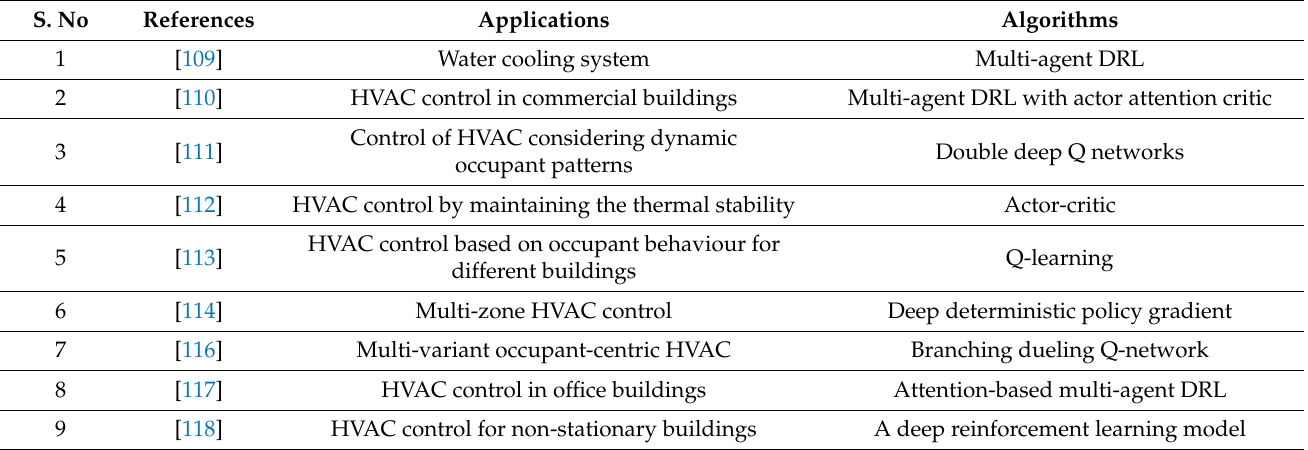
Table 4. Reinforcement learning applications for HVAC